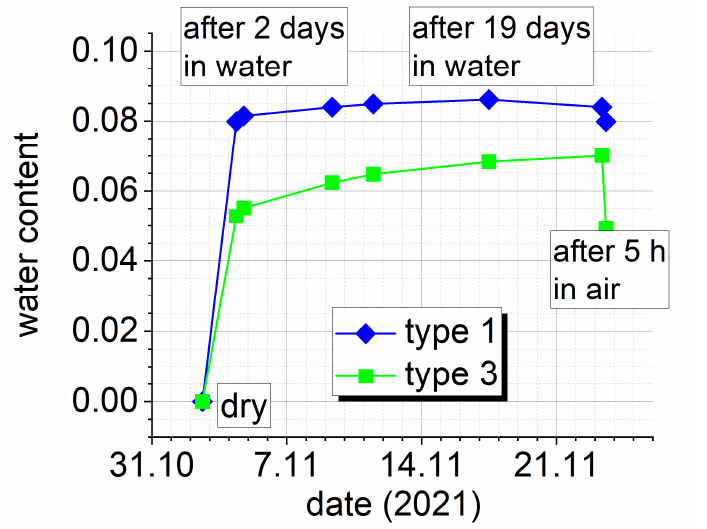
Figure 6. Increase in water content (moisture) during a period of 19 days of soaking and a sudden drop after 5 h drying in air.